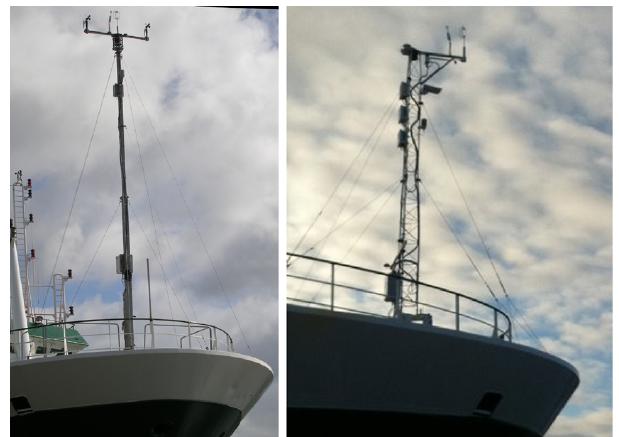
Fig. 2. Photos of the two masts that have been used in this study: left is the single pole mast with a crossbeam for the anemometers. Right shows the triangular lattice mast with the sonic anemometer located on a boom towards the